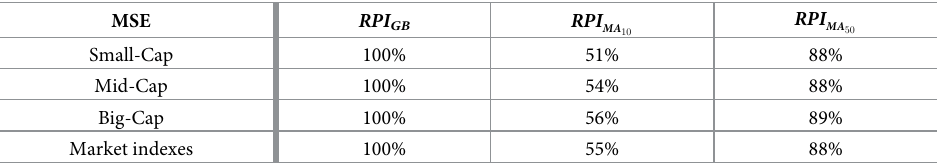
Table 1. Average RPI values for stocks in different market-cap categories and average RPI values for market indexes ( M =